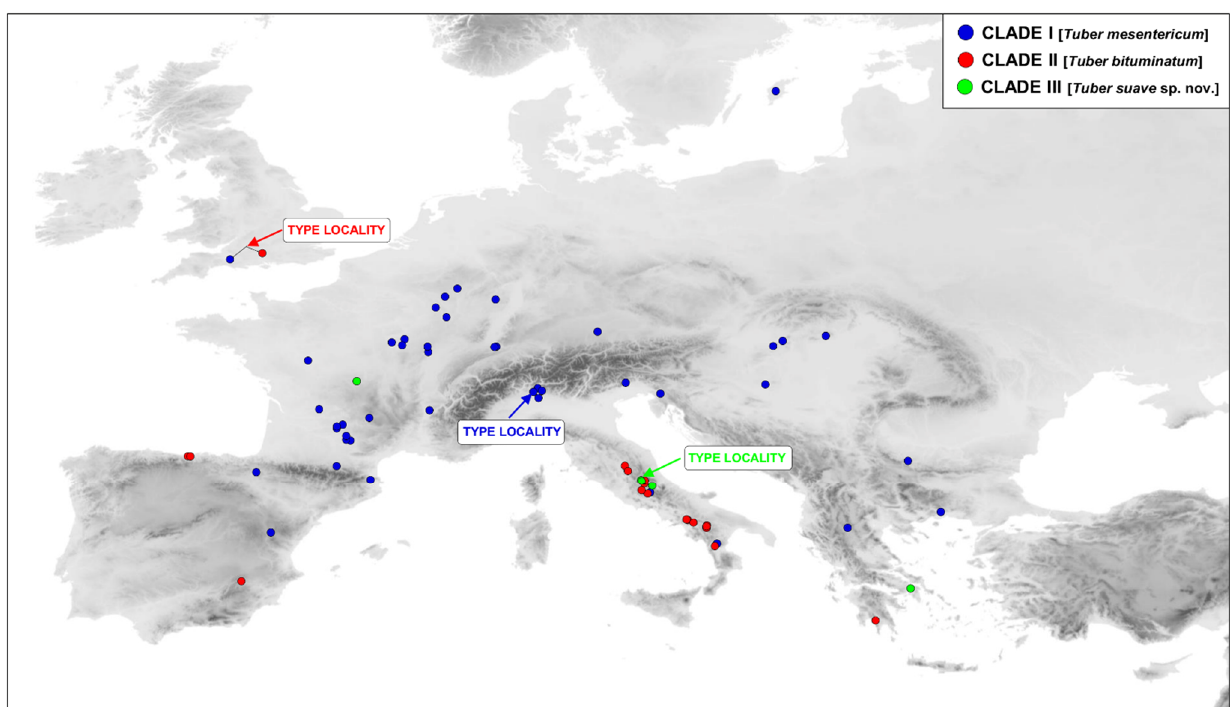
Figure 3. Geographic distribution of main clades, based on specimens analyzed in this study. For each clade, the corresponding taxon and type locality are indicated.